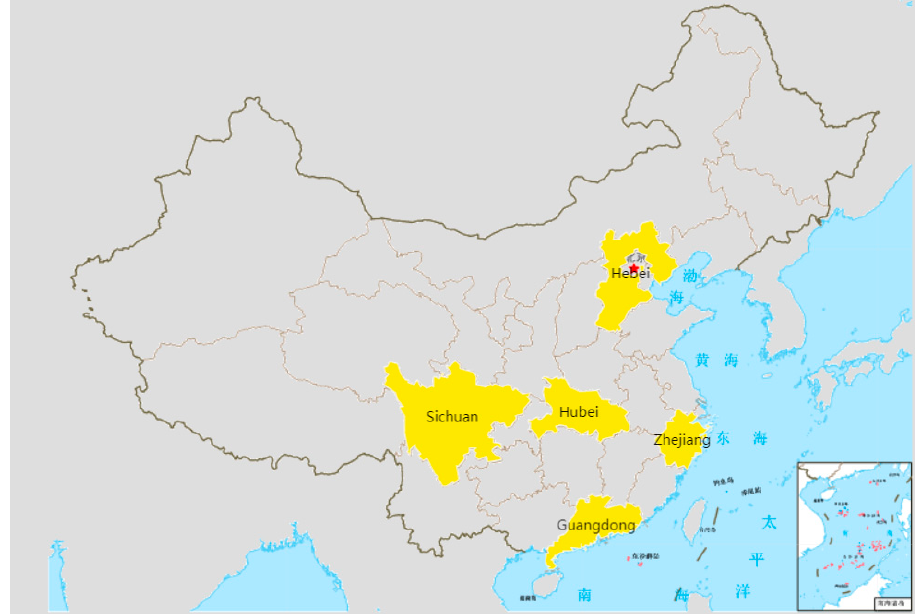
Figure 2. Map of the sample collection sites in China.